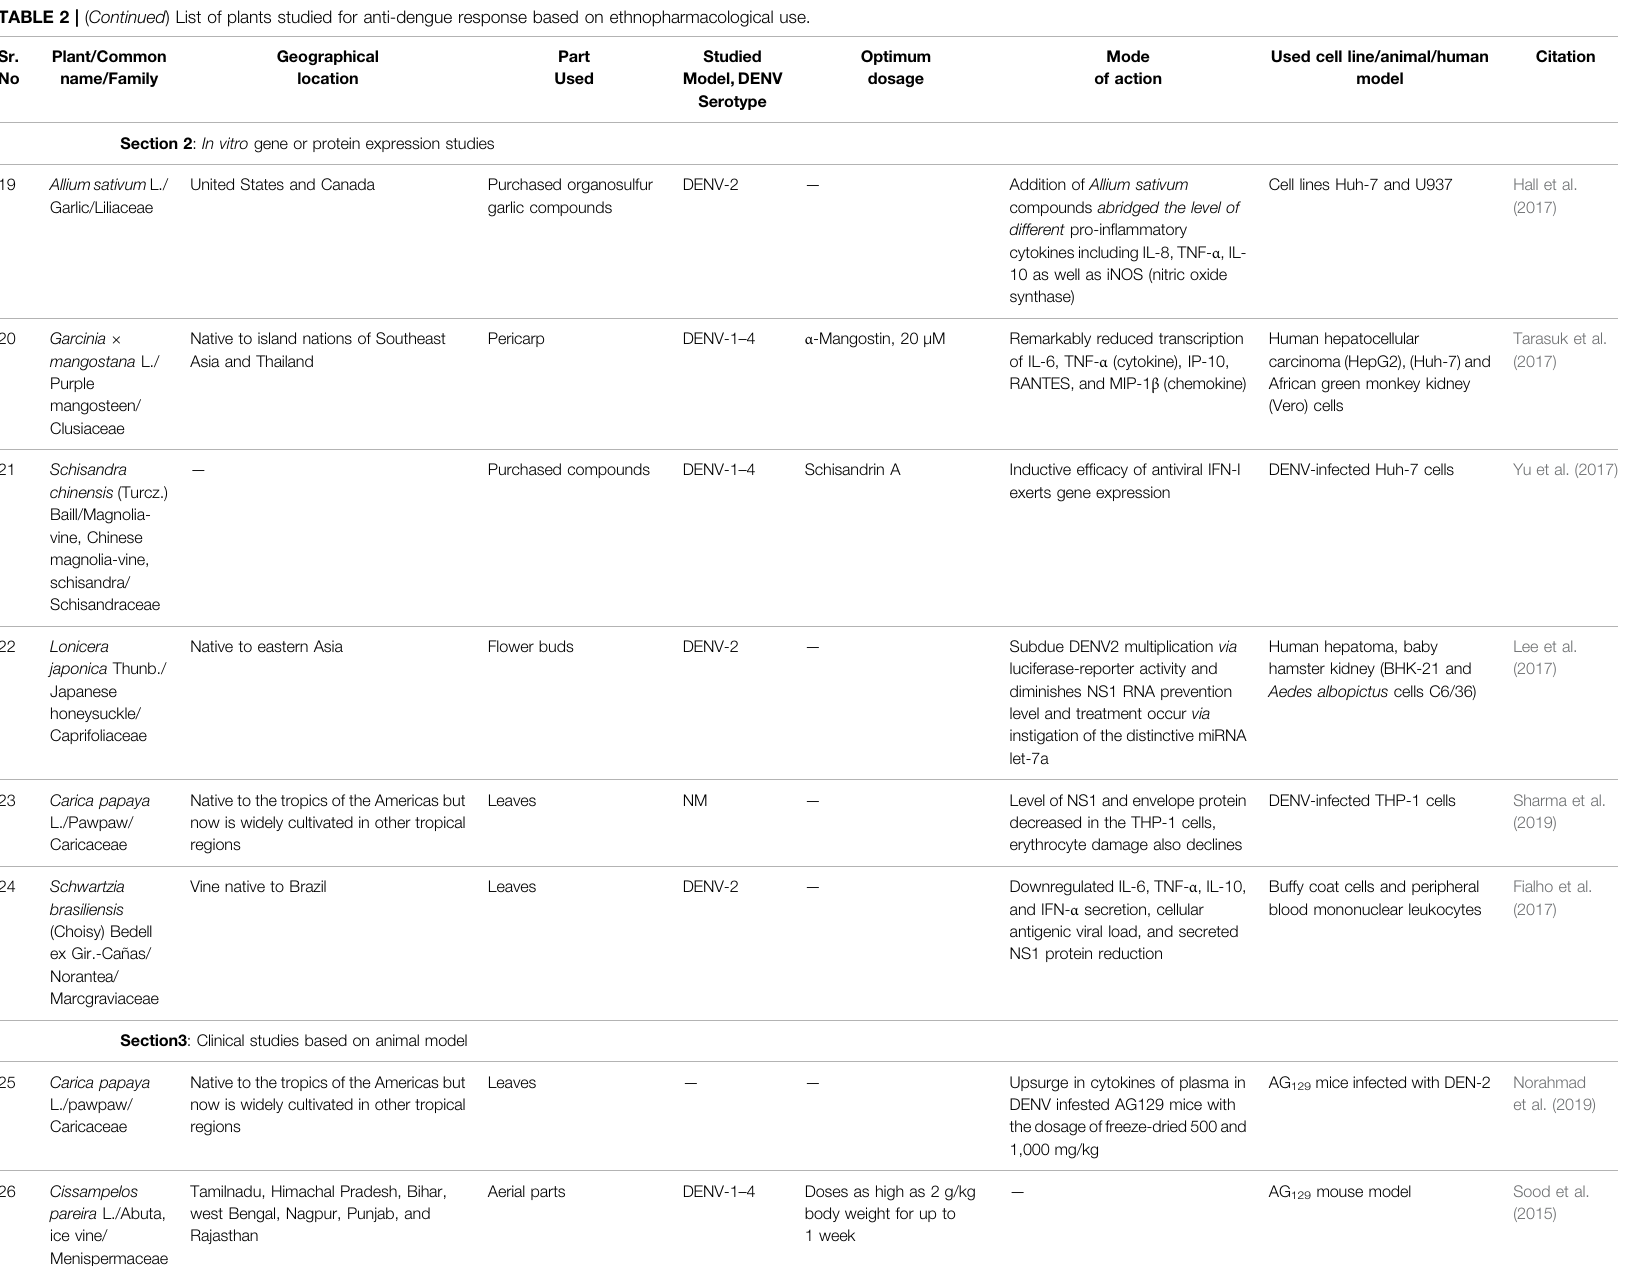
Section 2 : In vitro gene or protein expression studies